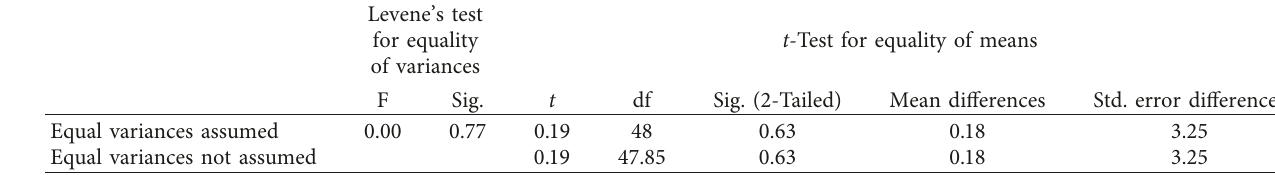
Table 2: Independent-samples t -test (reading pretest of the two groups).